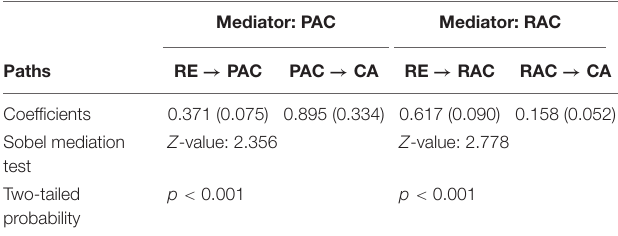
TABLE 3 | Results of mediation